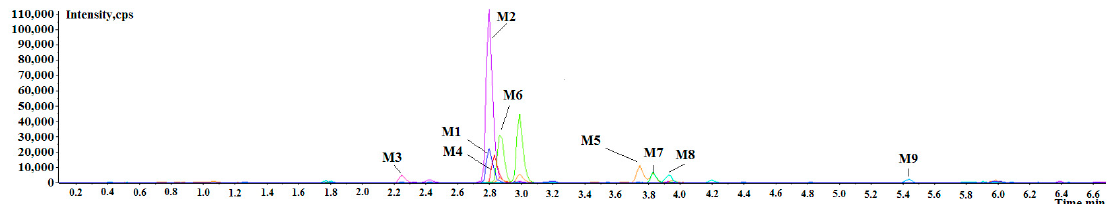
Figure 3. The extracted ion chromatogram of the berberine metabolites M1–M9 in rat plasma. Table 1. Metabolites of berberine detected by UHPLC–ESI–Q–TOF–MS/MS in rat plasma. Meta-B